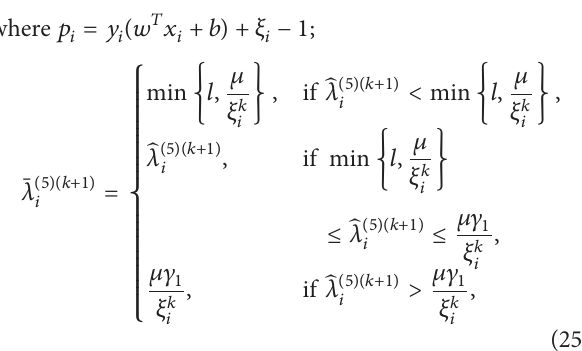
Algorithm 4. Algorithm for solving 𝐿 1/2 -SVM problem is as